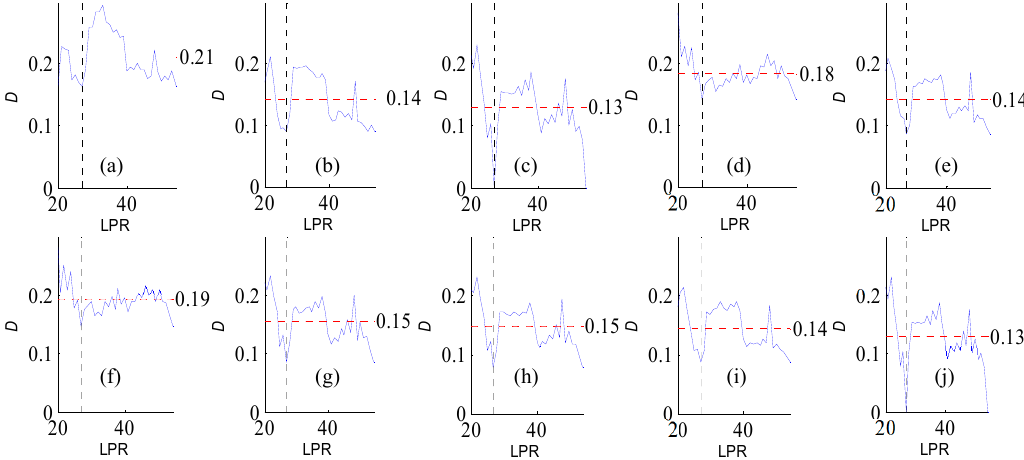
Figure A5. Variation of flow regime alteration degree (D) measured by the RVA with change in the length of pre-impact flow time series (LPR) under a periodicity of 27 years. ( a – j ) correspond to pre-impact flow time series length = 19, 23, 27, 31, 35, 39, 42, 46, 50, and 54 years, respectively. The abscissa value for the vertical dotted line is 27. The ordinate value for the horizontal dotted line is the mean degree of flow regime alteration in each subfigure. Water 2020 , 12 , x FOR PEER REVIEW